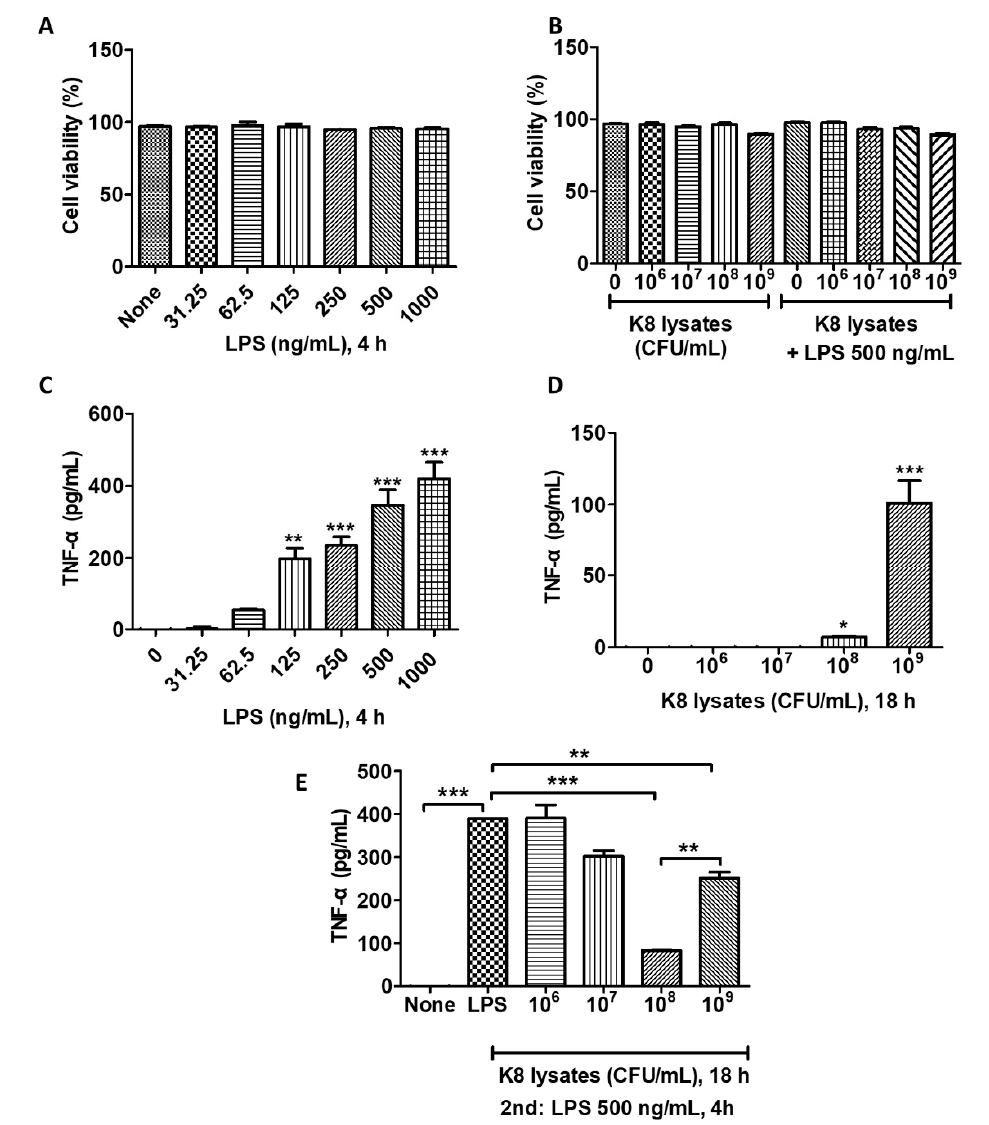
Figure 1. L. plantarum K8 lysates inhibited lipopolysaccharide (LPS)-induced tumor necrosis factor (TNF)- α production in THP-1 cells. ( A ) THP-1 cells were treated with LPS at the indicated concentrations for 4 h. ( B ) THP-1 cells were pretreated with L. plantarum K8 lysates at the indicated concentrations for 18 h and treated with 500 ng/mL LPS for 4 h. In ( A , B ), cell viability was measured using Trypan blue staining method. ( C ) THP-1 cells were treated with LPS at the indicated concentrations for 4 h. ( D ) THP-1 cells were treated with L. plantarum K8 lysates from 1 × 10 6 to 1 × 10 9 colony forming unit (CFU)/mL for 18 h. ( E ) THP-1 cells were pretreated with L. plantarum K8 lysates at the indicated concentrations for 18 h and treated with 500 ng/mL LPS for 4 h. In (C-E), the TNF- α level in the culture supernatants was determined using enzyme-linked immunosorbent assay (ELISA). Statistical analysis was conducted with one-way ANOVA followed by Tukey’s HSD post hoc test. * p < 0.05; ** p < 0.01; *** p < 0.001.